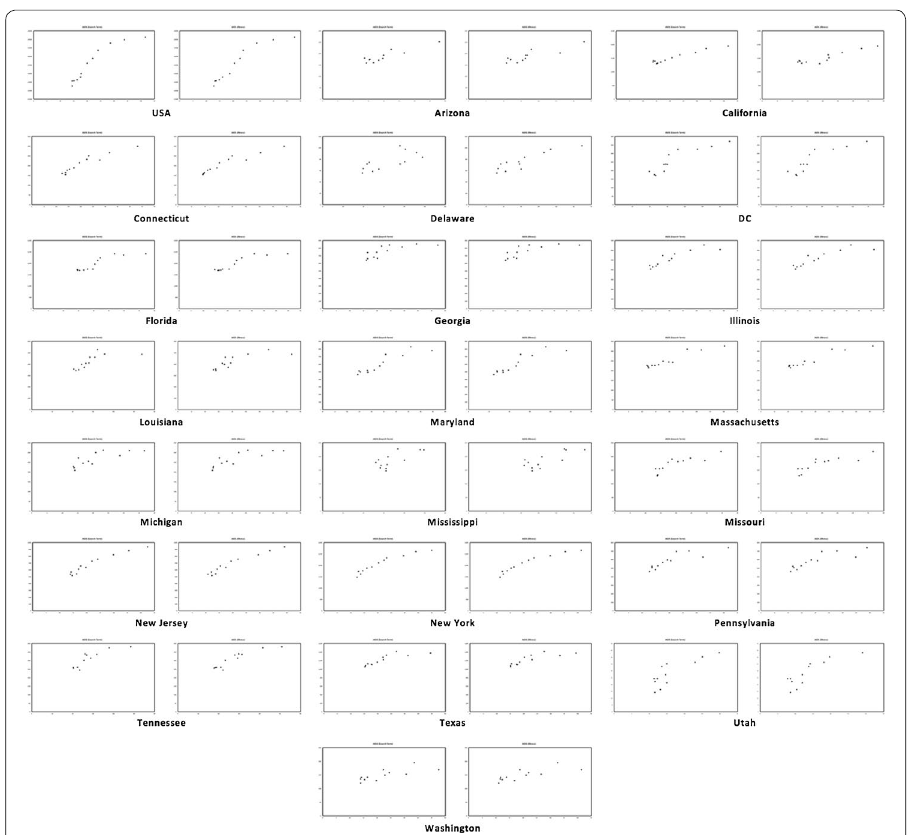
Fig. 9 ‘AIDS Deaths’ vs. Google Trends ‘AIDS (Search Term)’ and ‘AIDS (Illness)’ from January 2004 to December